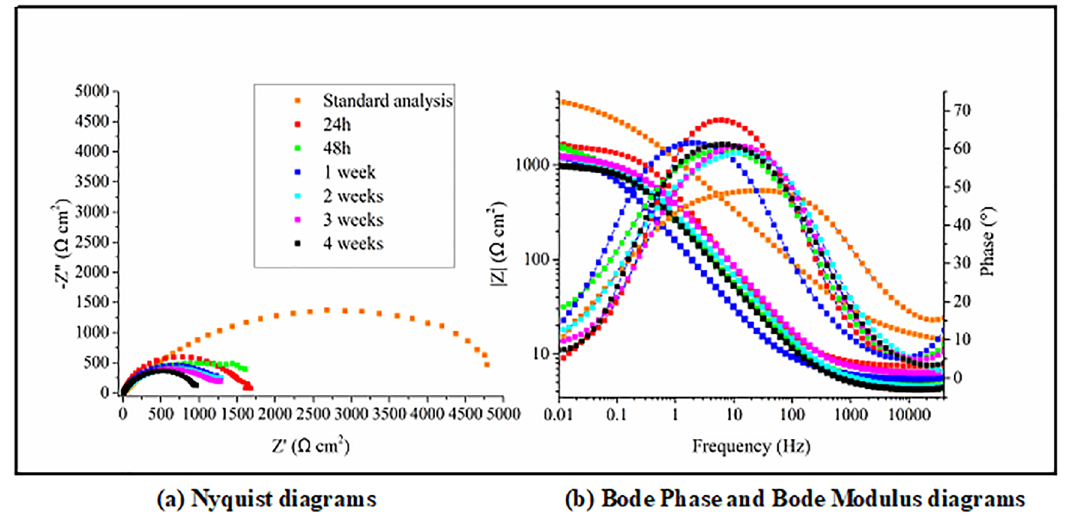
Figure 7. Study S2: (a) Nyquist diagrams and (b) Bode Phase and Bode Modulus diagrams plotted for carbon steel exposed in diesel oil S10 contaminated with saline water for 30 days.